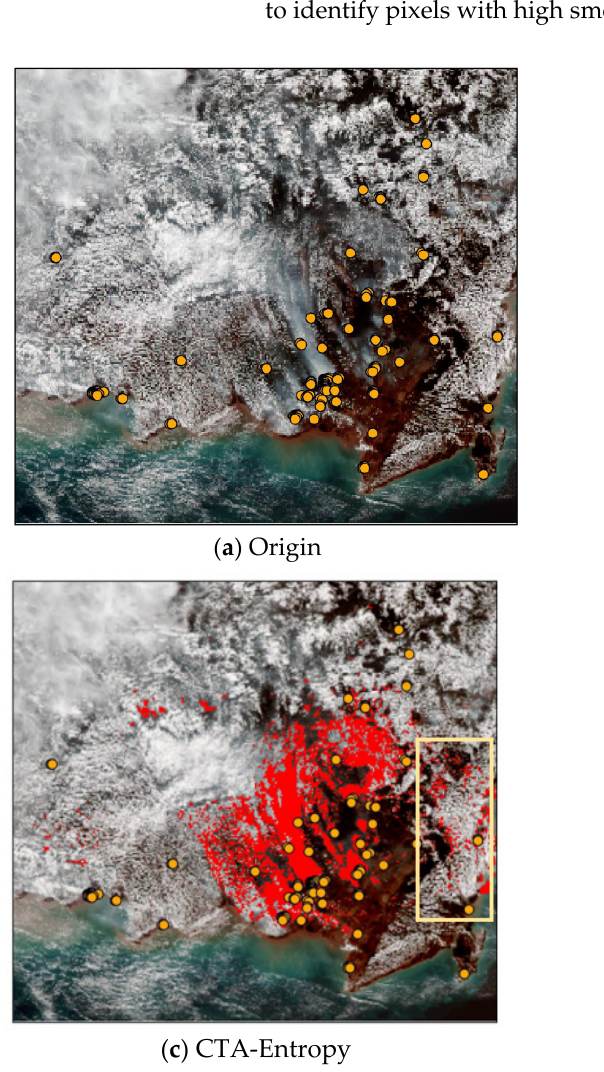
Figure 5. The detailed visualization results of test data at 05:00 on 30 August 2015, where the red region is the prediction of smoke by models and orange spots are the hot spots.